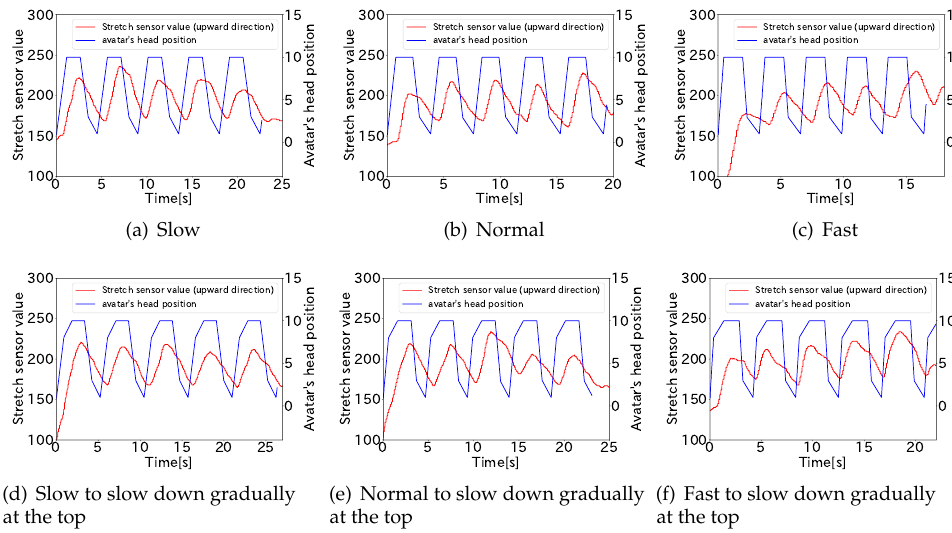
Figure A3. Stretch sensor values at each stretch speed in the upward direction (Participant D).